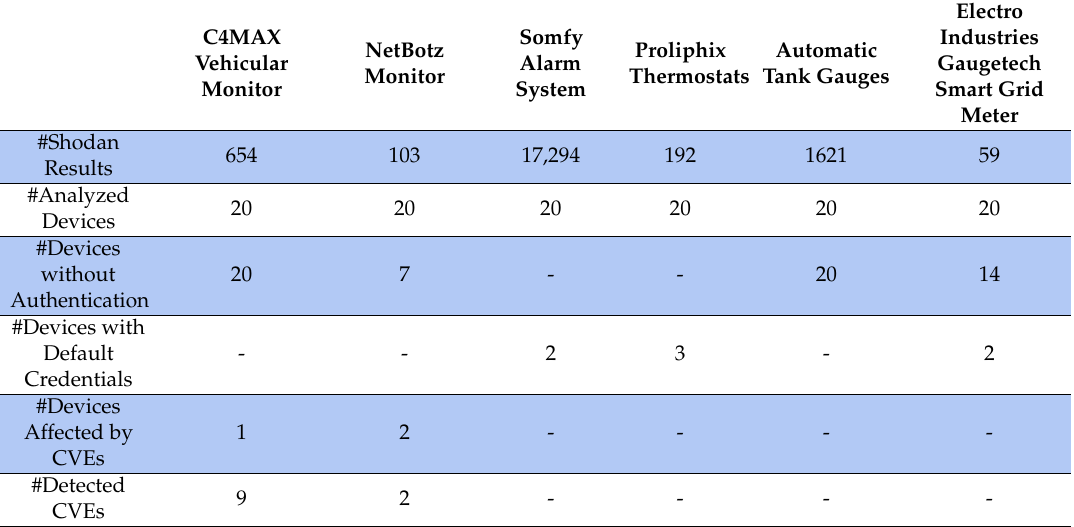
Table 3. Examples of the results obtained by the